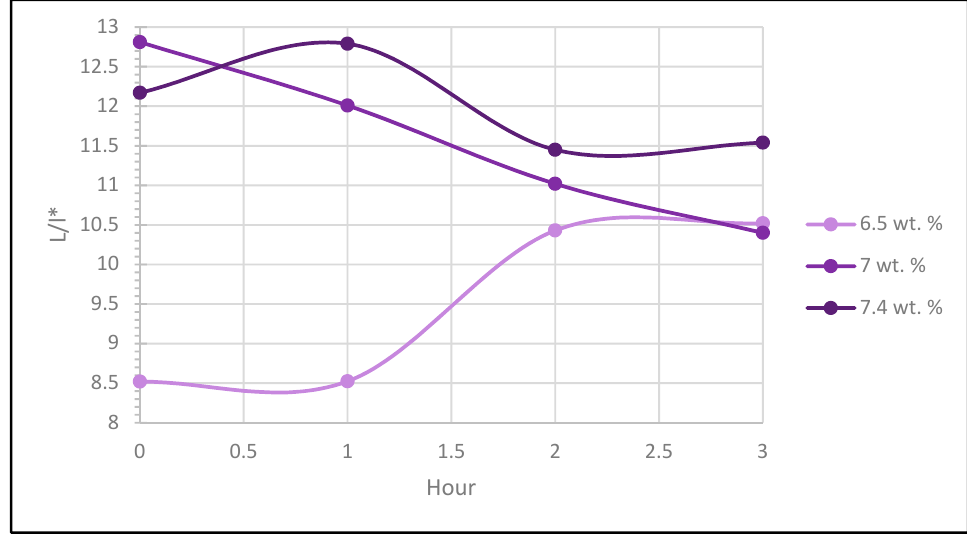
Figure 10. L/l* values for 6.5 wt %, 7 wt %, and 7.4 wt % CAPB and SLES, 15 wt % avocado oil emulsions over 3 ‐ h period.